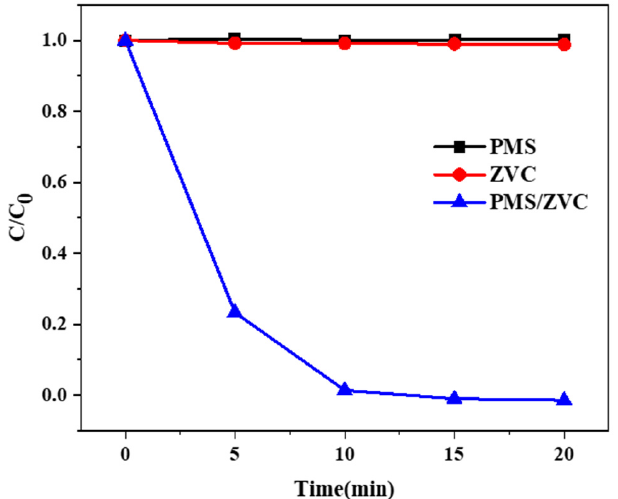
Figure 2. The OG degradation in different systems. Condition: [OG] = 50 mg/L, [PMS] = 3 mM, [ZVC] = 0.3 g/L.